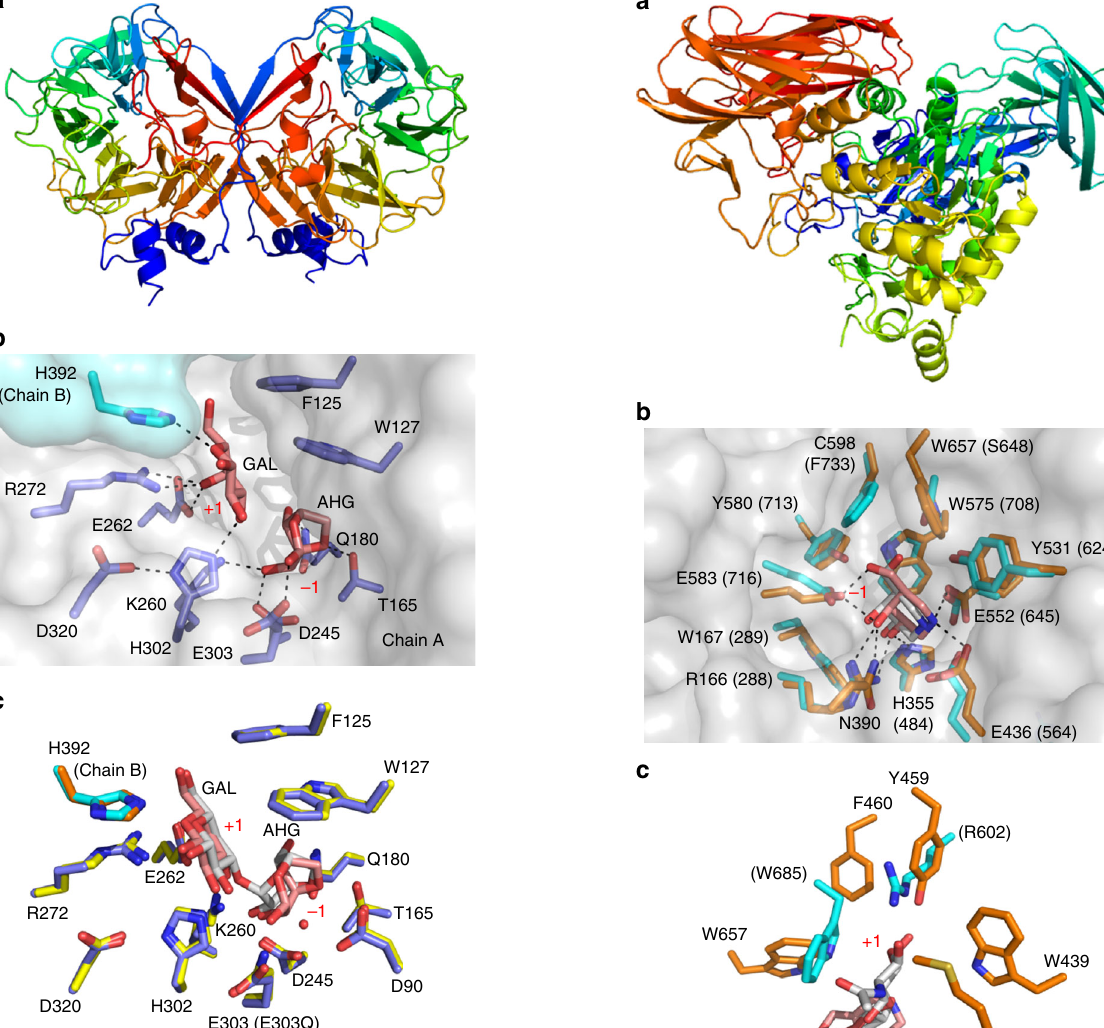
Fig. 4 Molecular basis of the exo- acting α -1,3- L -neoagarooligosaccharide hydrolase GH117B. a Structure of the GH117B dimer shown in cartoon format with each monomer color ramped from N terminus (blue) to C terminus (red). b Surface representation of chain A (gray) and chain B (cyan) of the GH117B catalytic pocket. Key residues are labeled (blue) and N2 digestion products GAL and AHG are shown in stick format (pink). c Structural alignment of GH117B (blue) in complex with GAL and AHG (pink) with Bp GH117 (yellow) in complex with N2 (gray) (pdb entry